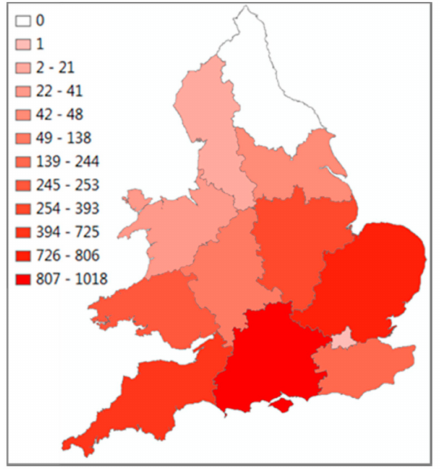
Figure 6. Modelled annual output for solar farms 2014, MWh.